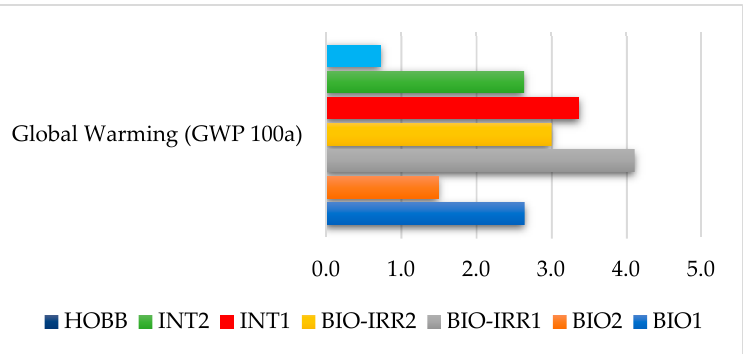
Figure 3. Global Warming of the entire life cycle in terms of kg of CO 2 eq per litre of bottled oil produced.